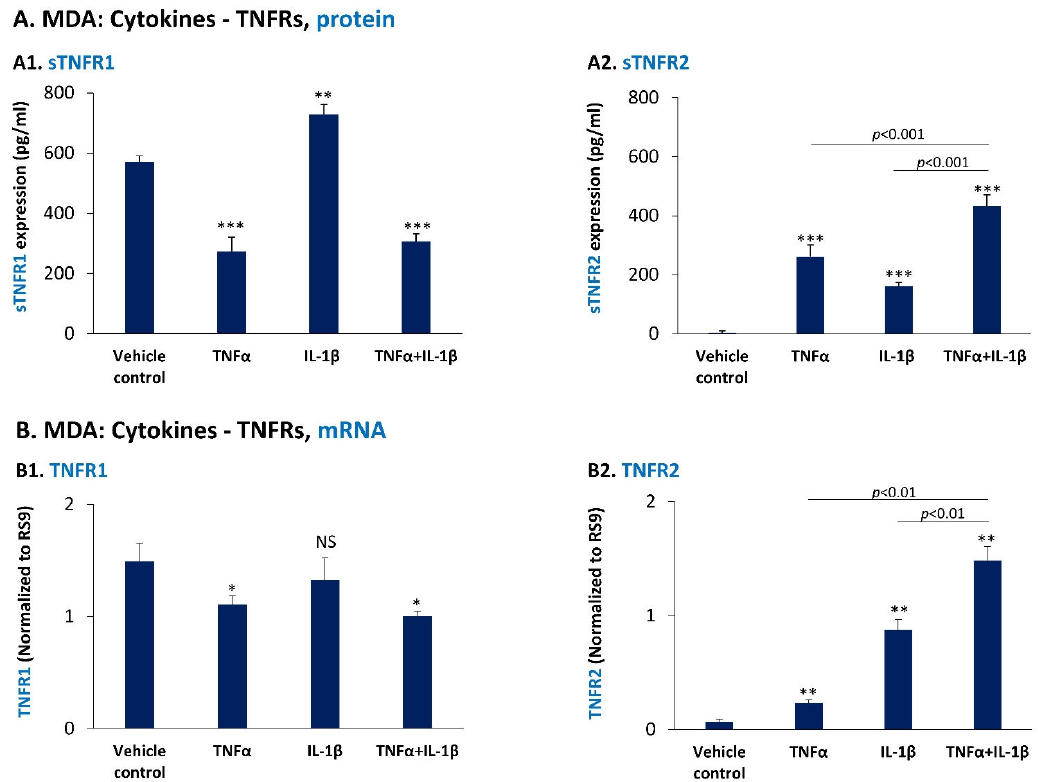
Figure 7. Pro ‐ inflammatory cytokines up ‐ regulate the expression of cell ‐ derived sTNFR2 by MDA ‐ MB ‐ 231 cells, but have a divergent effect on cell ‐ derived sTNFR1 expression levels. ( A ) MDA ‐ MB ‐ 231 cells (MDA) were stimulated by TNF α and/or IL ‐ 1 β (concentrations as in Figure 1) or treated by a vehicle control for 48 h. sTNFR1 ( A1 ) and sTNFR2 ( A2 ) levels were determined in CM of the cells by ELISA. In each panel, a representative experiment of n = 3 is presented. *** p < 0.001. ** p < 0.01. ( B ) MDA cells were stimulated by TNF α and/or IL ‐ 1 β (concentrations as in Figure 1) or treated by a vehicle control for 5 h. TNFR1 mRNA ( B1 ) and TNFR2 mRNA ( B2 ) levels were determined by qPCR. In each panel, a representative experiment of n = 3 is presented. ** p < 0.01, * p < 0.05. NS, Not significant. Statistical analyses were performed as described in Section 2.